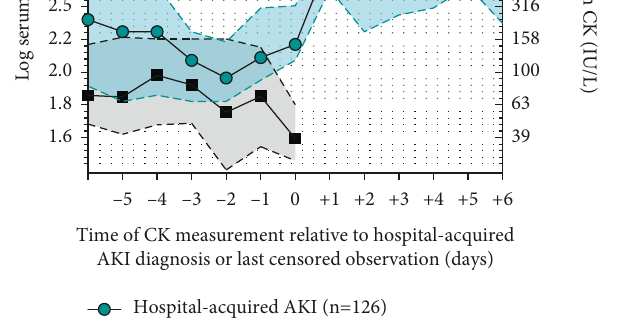
Figure 1: Longitudinal trajectory of serum CK measurements relative to the time for hospital-acquired AKI diagnosis or last censored observation. Green and black correspond to observed means of log serum CK concentrations (a) or CK concentrations in IU/L (b) for subjects with hospital-acquired AKI and without AKI respectively; 95% confidence intervals are represented in shaded